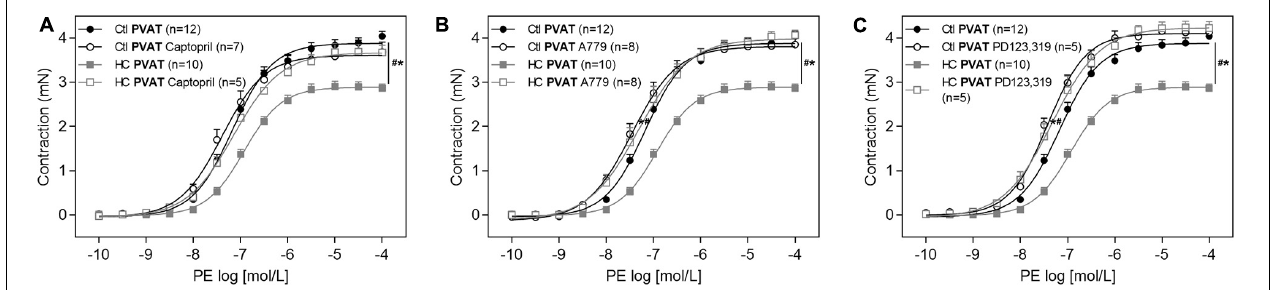
FIGURE 5 | Involvement of RAS in the effect of HC diet on the PVAT control of vascular tone. Cumulative concentration-response curves for PE in the presence of PVAT in aortas of control and HC groups previously incubated or not with (A) captopril, (B) A779, or (C) PD123,319. Values represent mean ± SEM. The total number of animals required to carry out the experiments in each group ( n ) is presented in parentheses in the graphs. Statistical significance was determined using two-way ANOVA followed by Holm–Sidak’s post hoc test. * p < 0.05 vs. control PVAT; # p < 0.05 vs. HC PVAT represent the differences in the Emax and pD 2 values.